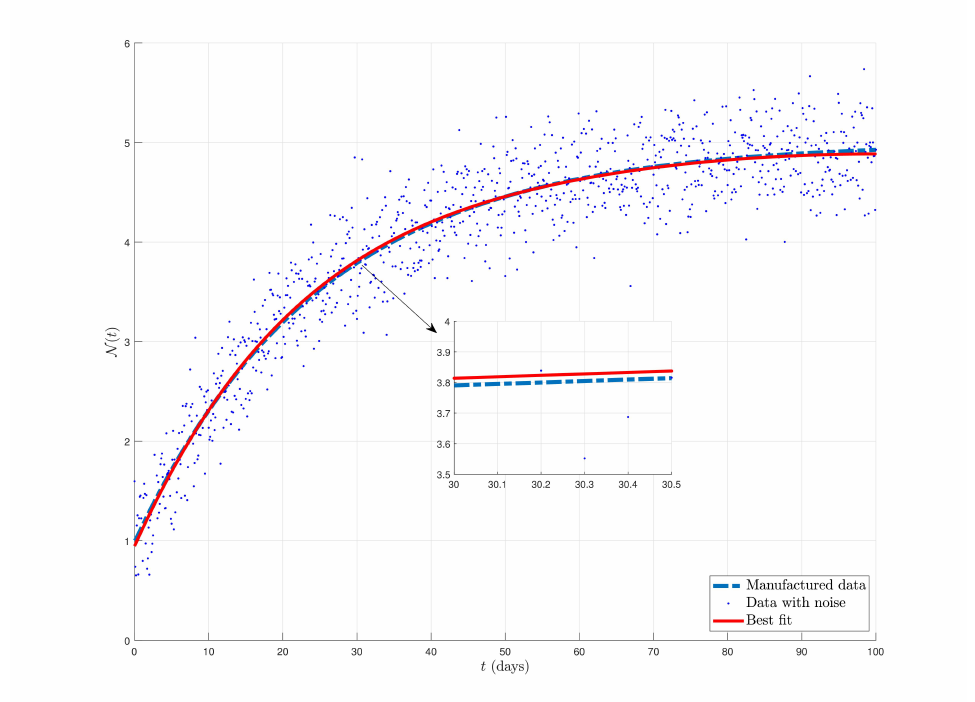
Figure 1. Comparison between the approximate total population N ( t ) with noise data and curve of best